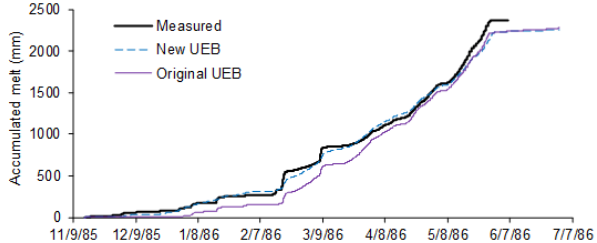
Figure 10. Comparisons of accumulative melt in 1986 at CSSL.